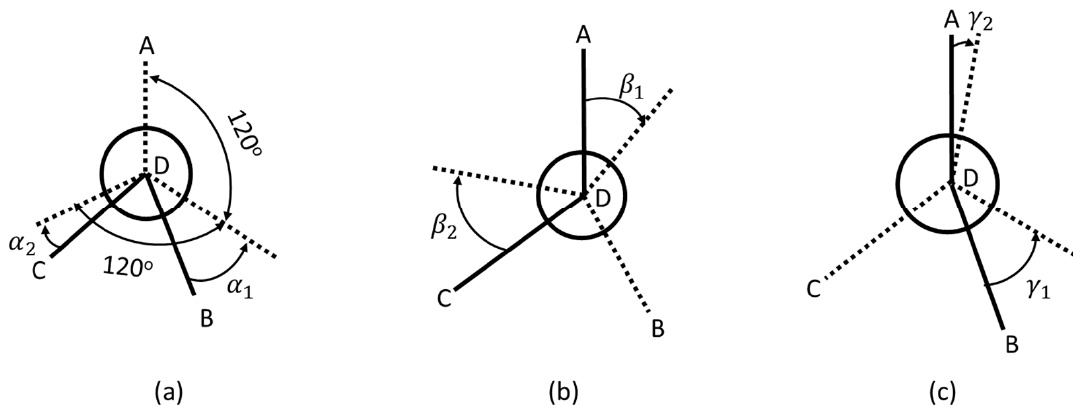
Figure 3. Particle arrangement in geometrical stability, first set ( a ), second set ( b ), third set ( c ). The sum of the variation from the stable configuration is calculated for each contact point; that is for three contacts, there are three values of d Sn and for each contact point, d Sn is the sum of two angles since the variation from the stable configuration for one contact must be zero. For the first set (Figure 3a):